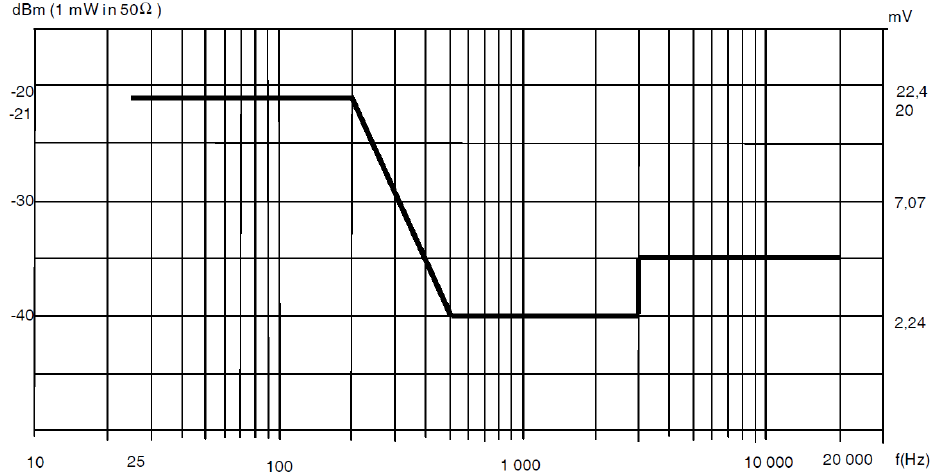
Figure 8. Profile of harmonic and supraharmonic limits of emission for equipment in telecommunications and data centers, 48 Vdc, as per EN 300 132-2 [111] © ETSI 2019, all rights reserved. Measurement is carried out with 10 Hz resolution bandwidth up to 10 kHz and 200 or 300 Hz between 10 and 20 kHz.